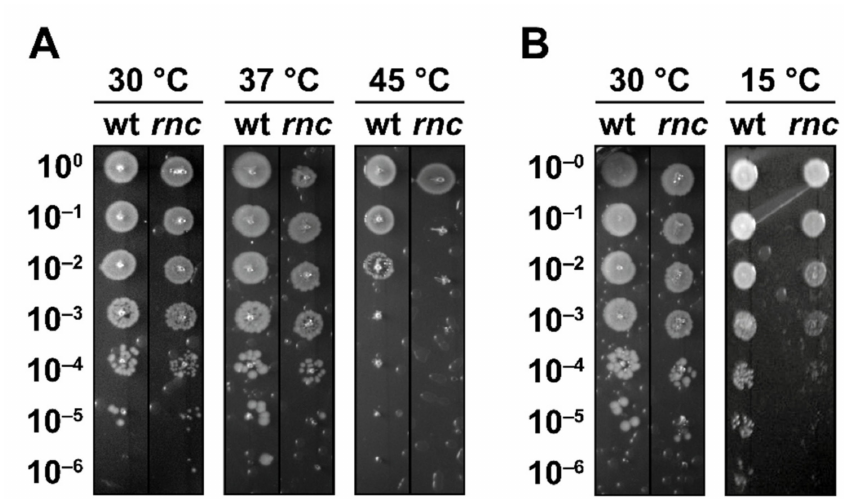
Figure 1. RNase III is required for survival at high and low temperatures. ( A ) N3433 (wt) and its rnc 105 ( rnc ) derivative were grown at 30 ◦ C before being shifted to 45 ◦ C for 15 min, and survival was assayed by droplet plating at 30, 37 and 45 ◦ C. ( B ) Strains wt and rnc were grown at 30 ◦ C and survival was assayed by droplet plating at 30 and 15 ◦